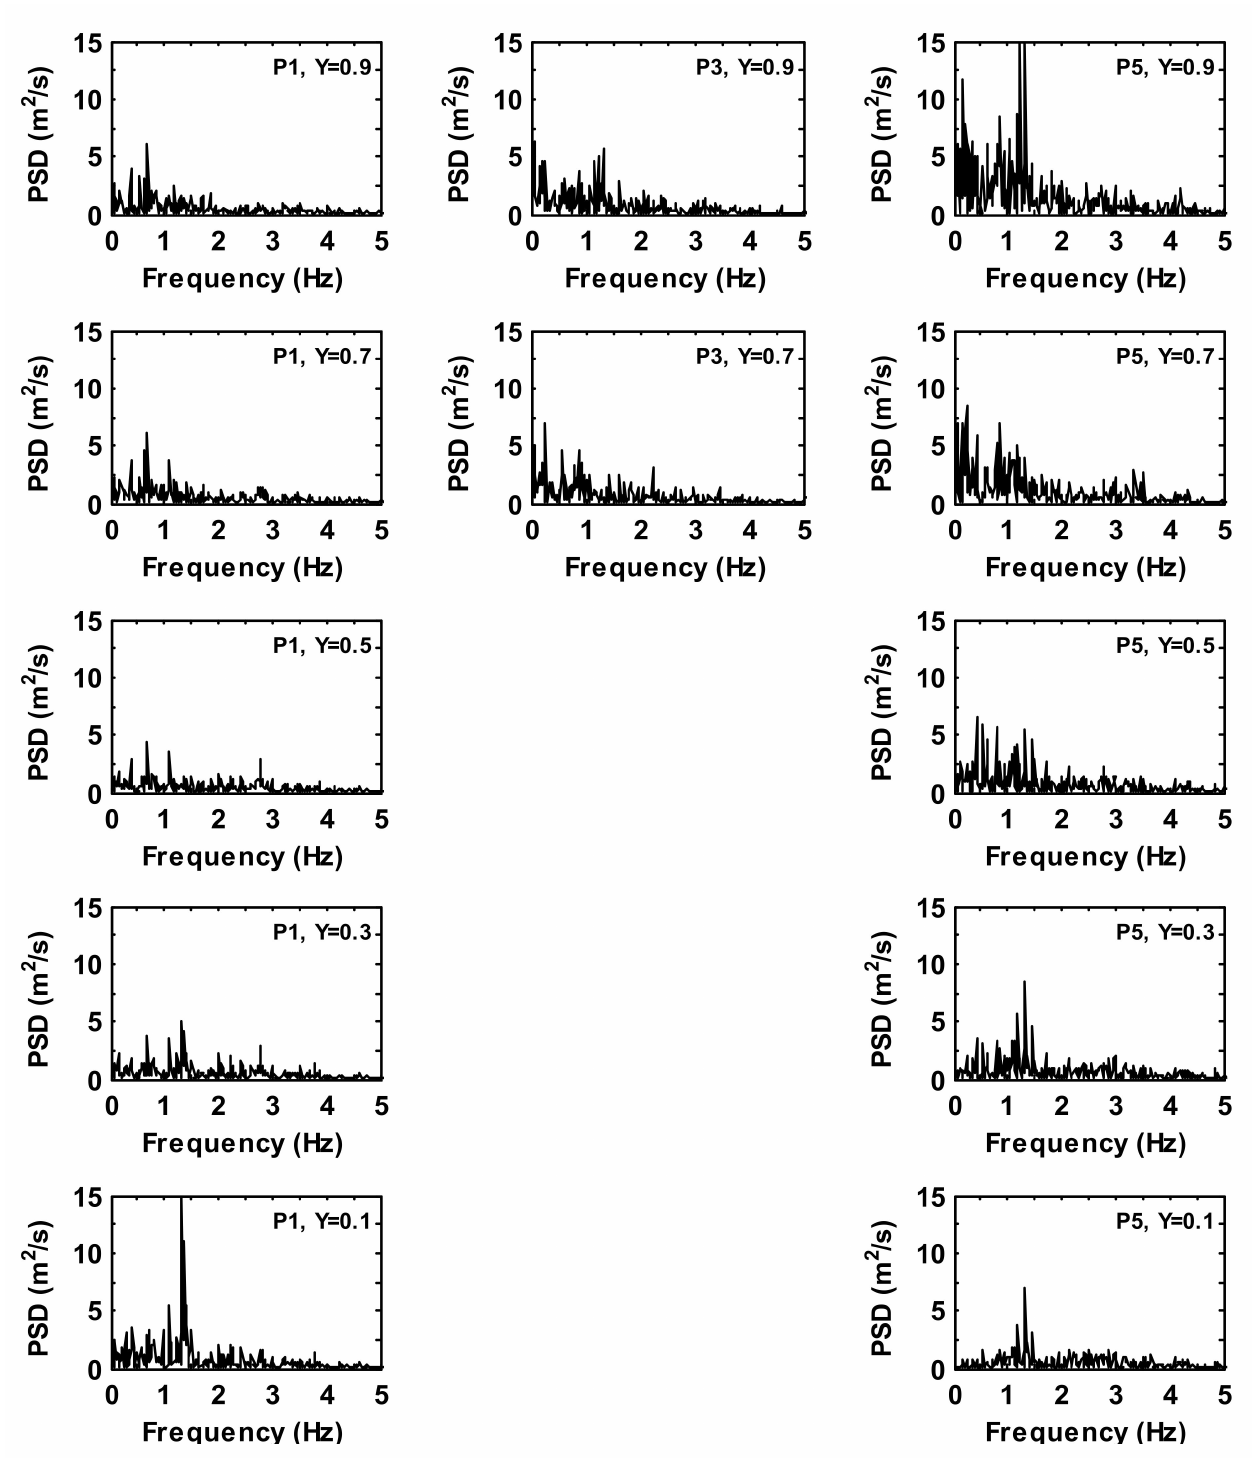
Figure 14. Power spectra density of the time history temperature fluctuations at monitoring locations P 1, P 3, P 5 for case